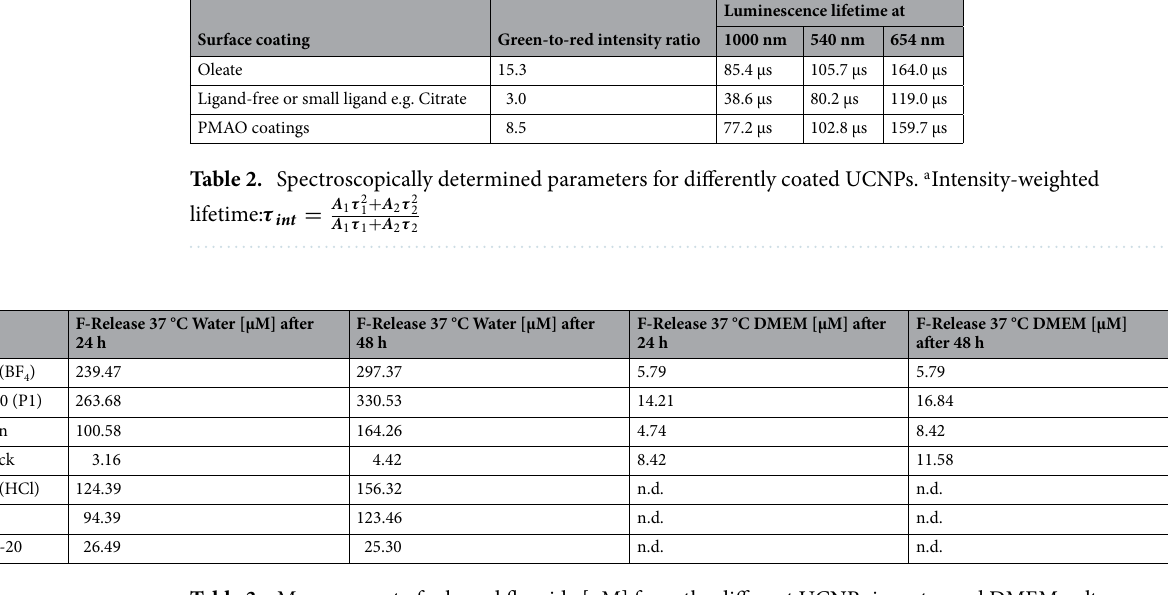
Table 3. Measurement of released fluoride [µM] from the different UCNPs in water and DMEM culture medium at 37 °C after 24 h and 48 h incubation. n.d.: not